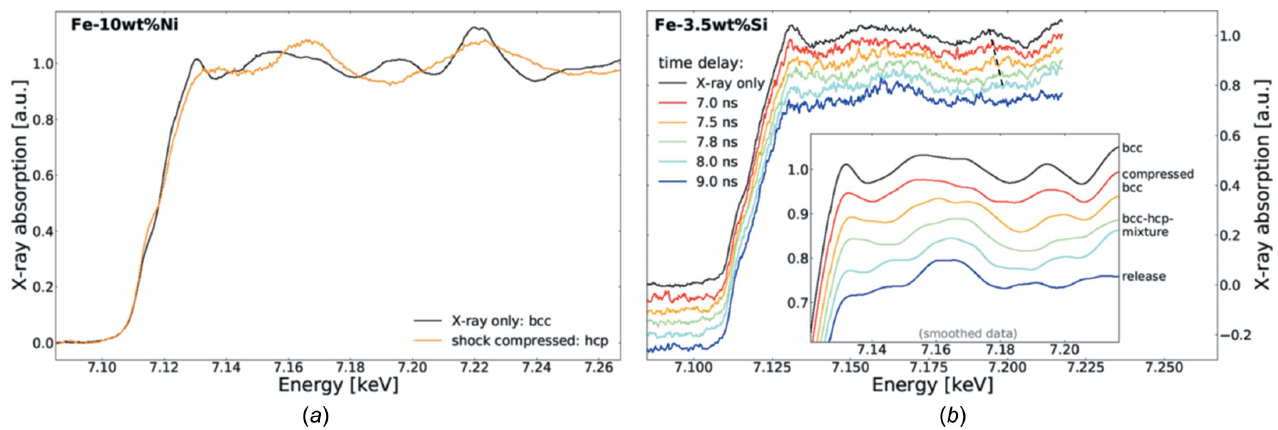
Figure 11 Normalized single-shot XAS spectra of ( a ) Fe–10 wt%Ni (4-bunch mode) and ( b ) Fe–3.5 wt%Si (7/8+1 bunch mode) recorded at various time delays between the optical laser and X-ray pulses. The spectra under ambient conditions, representing the bcc structure, are shown in